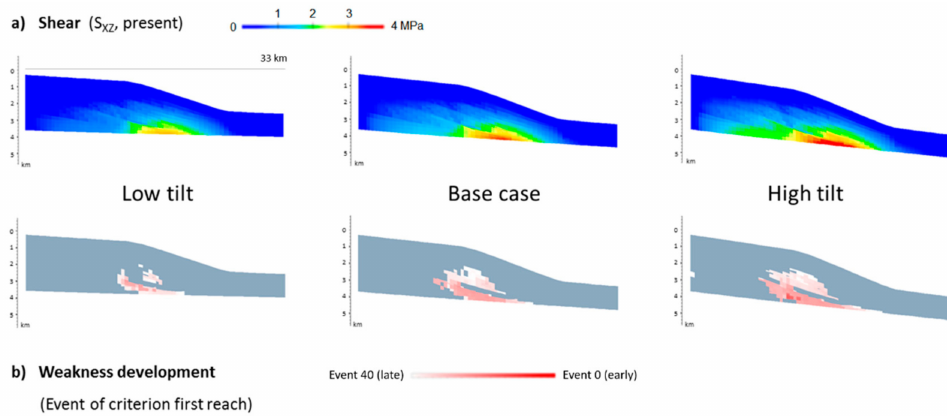
Figure 9. Influence of subsidence tilt on weakness development: globally. ( a ) present-day shear simulated on the three scenarios; ( b ) event of criterion first reach in the three scenarios: the stronger the red color, the earlier the area becomes weak; vertical exaggeration ×